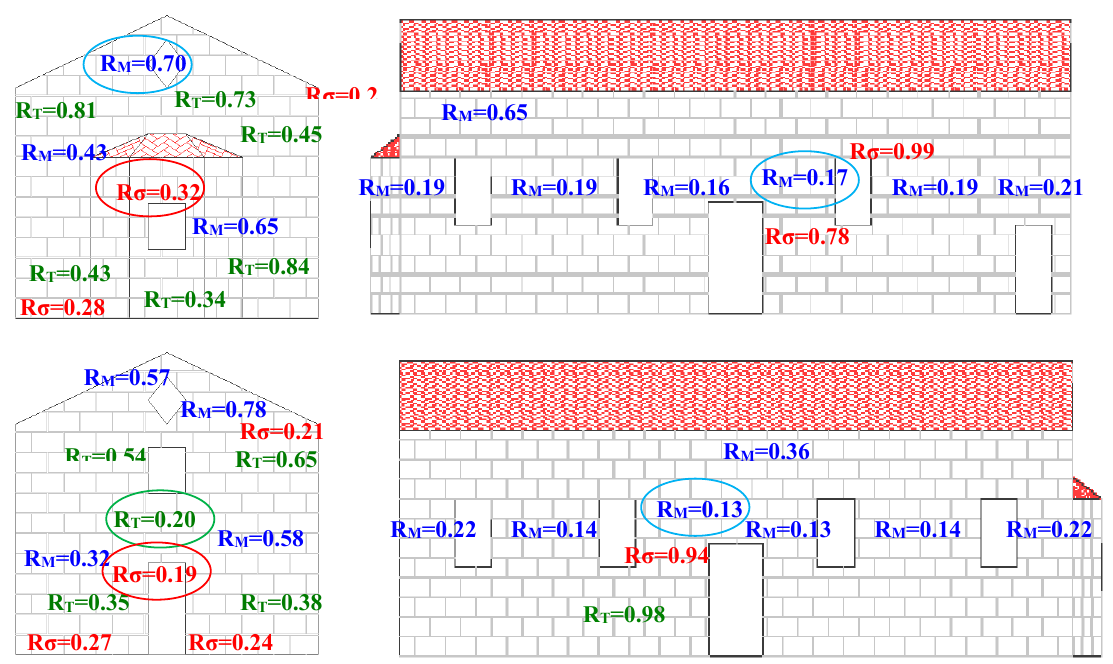
Figure 16. Summary results of the evaluation process in terms of R τ , R σ , R M ratio values, for moderately deformable foundation (axial stiffness value of supporting links equal to 24.5 KN/mm).